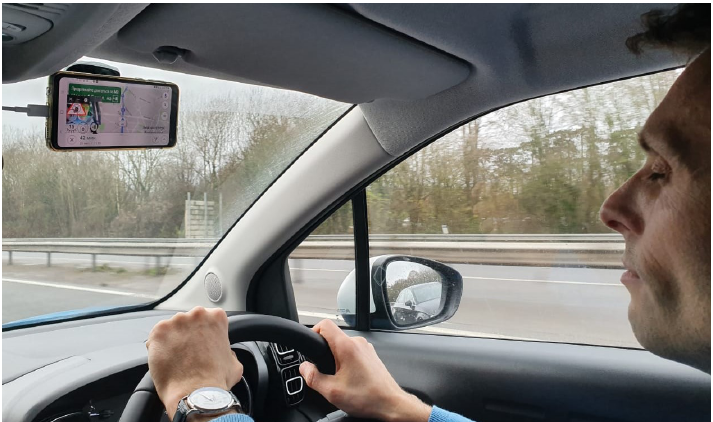
Figure 2. Driver data collection and dangerous state detection by using a smartphone with Drive Safely application.